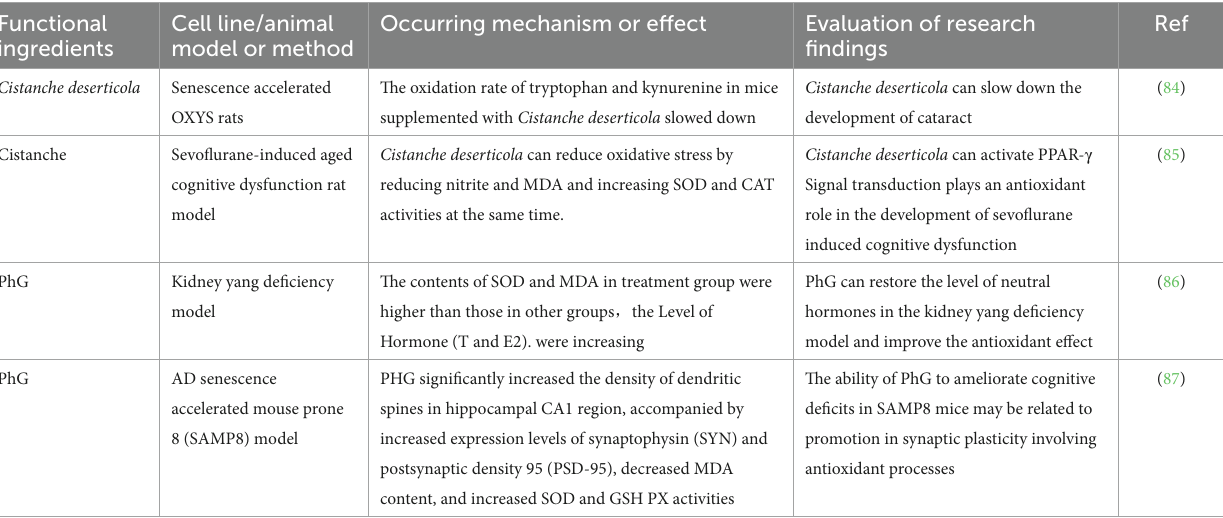
TABLE 9 Antioxidant effect mechanism of